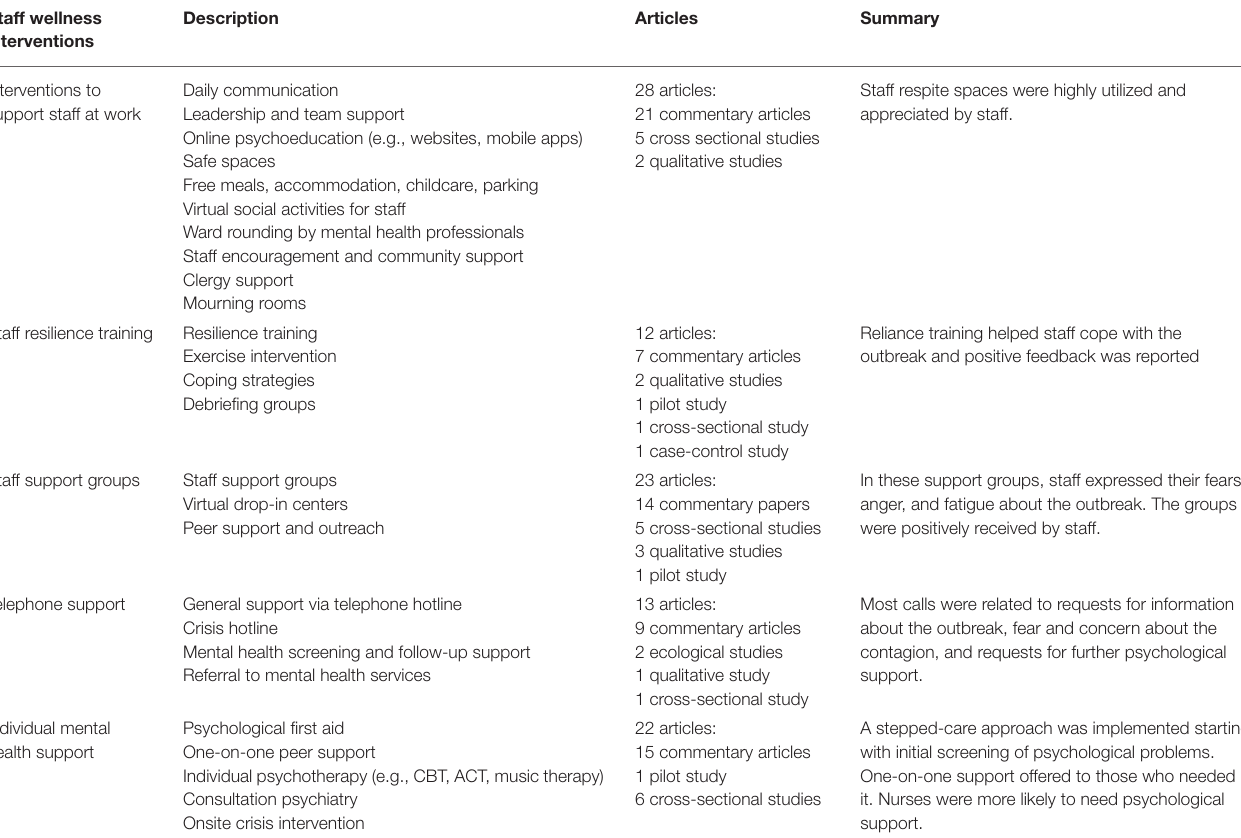
TABLE 1 | Most common themes in the